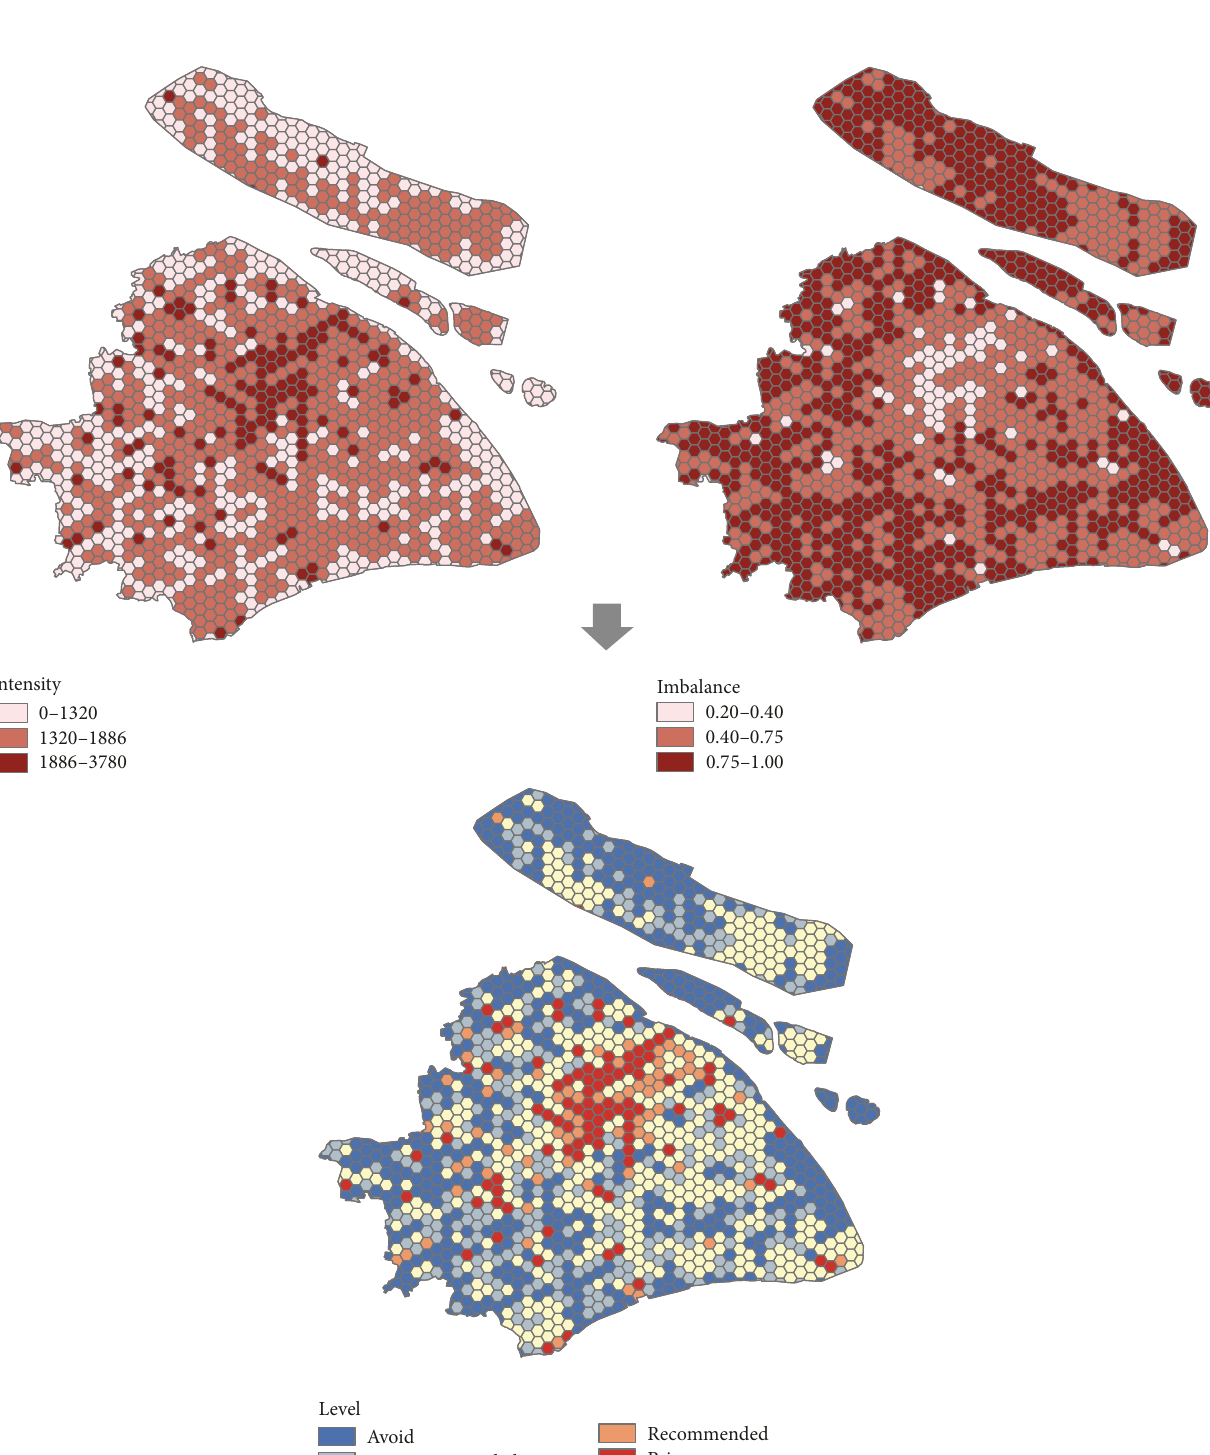
Figure 7: Combining usage intensity model and imbalance model to locating carsharing station in